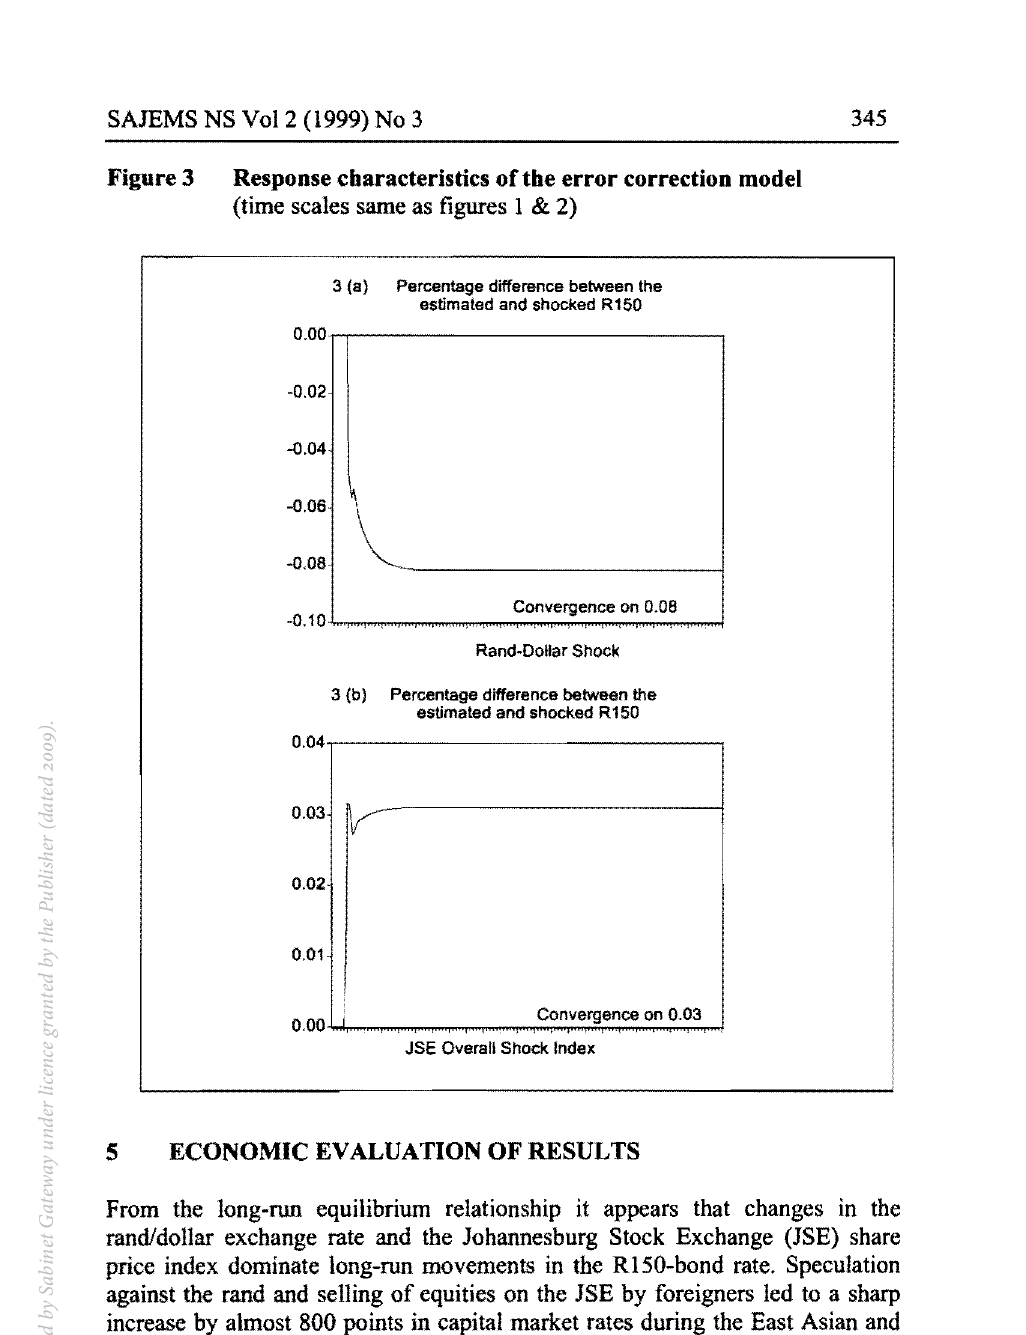
Figure 3 Response characteristics of the error correction model (time scales same as figures 1 &